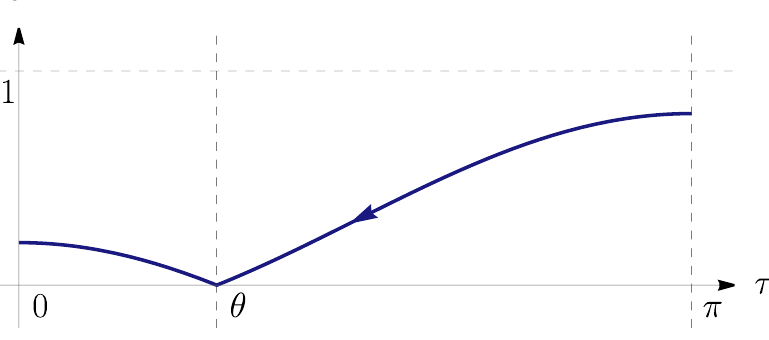
Figure 3 . The evolution of the cross ratio σ as τ is decreased from π down to 0 at fixed θ . Note that σ touches its minimum value, σ = 0 at τ = θ , when z